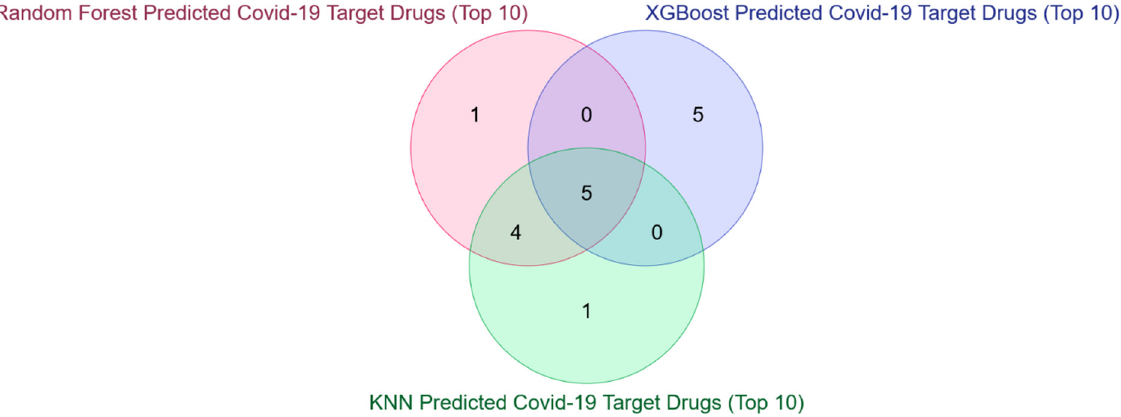
Figure 9. Overlap of top ten COVID-19Db-derived potential COVID-19 drugs for the unmatched/novel targets predicted by the three top-performing models. Table 3. Number of target-pathway interactions of the top five potential actionable COVID-19 re-